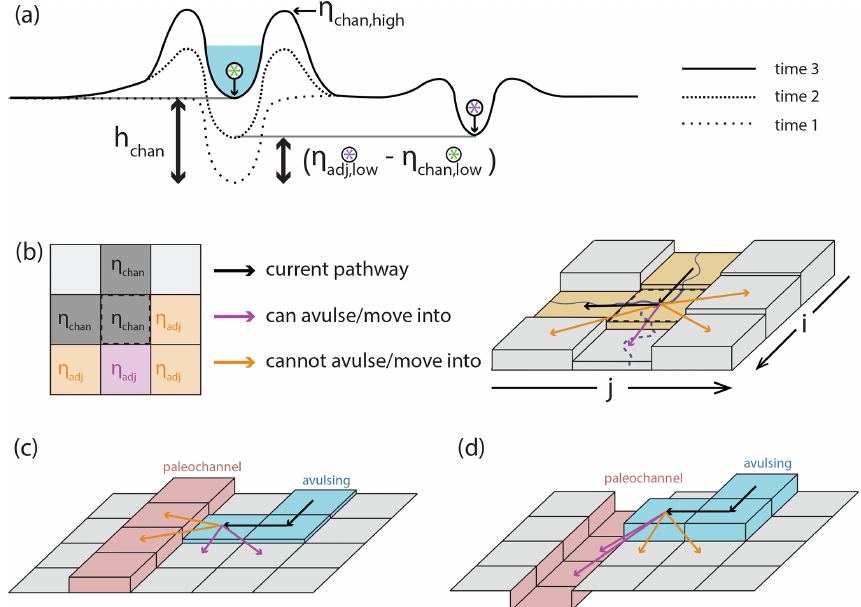
Figure 3. (a) Conceptual understanding of avulsion setup by superelevation and how the magnitude of in-channel aggradation necessary to achieve aggradation (black bidirectional arrows) differs if abandoned channels are ignored (left of active channel; Eq. 1) or considered (right of active channel; Eq. 2). (b) Representation of avulsion setup by superelevation in a 2-D cellular setting that considers adjacent elevations. Cells in the left panel are marked as η adj if they are adjacent to the center cell, highlighted by the dashed black line in the left and right panels. In this case, the cell is superelevated and enjoys a gradient advantage toward one cell (immediately down domain) and can thus avulse into this cell. The subscript “low” applies to all labeled cells but is omitted for legibility. Model representation of (c) abandoned channel repulsion and (d)